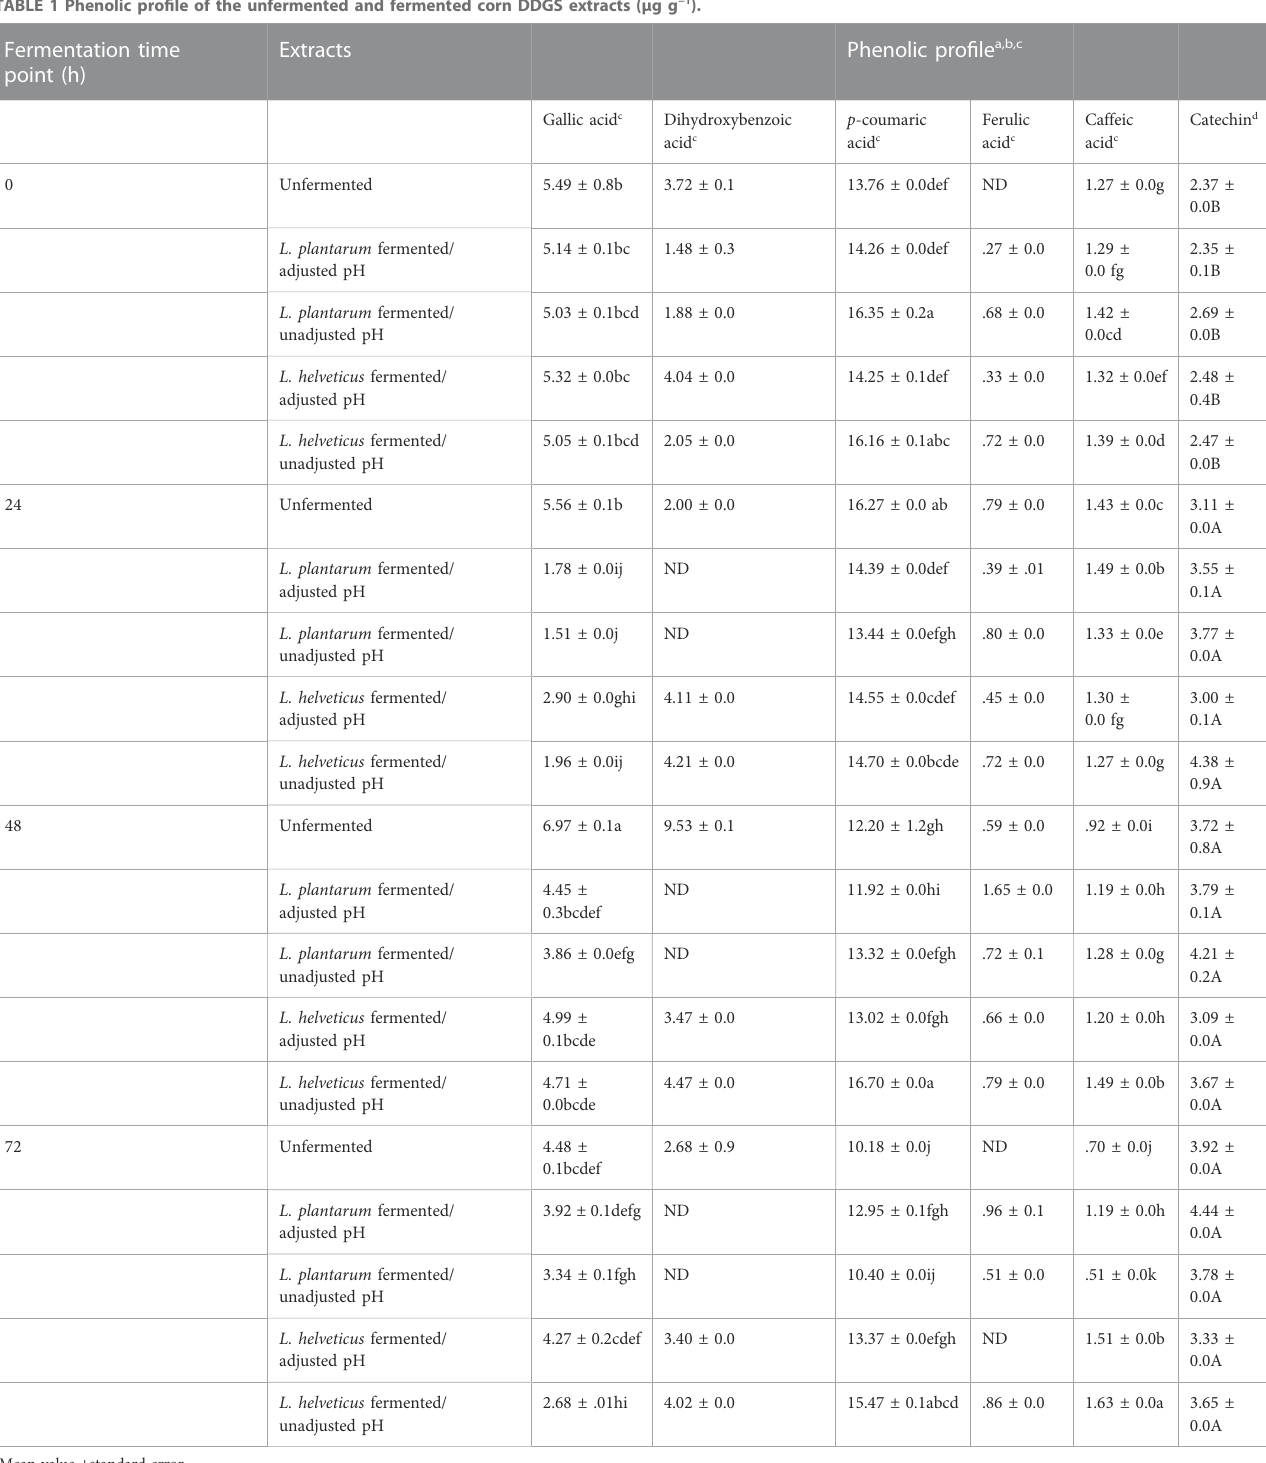
TABLE 1 Phenolic pro fi le of the unfermented and fermented corn DDGS extracts (µg g − 1 ). Fermentation time point